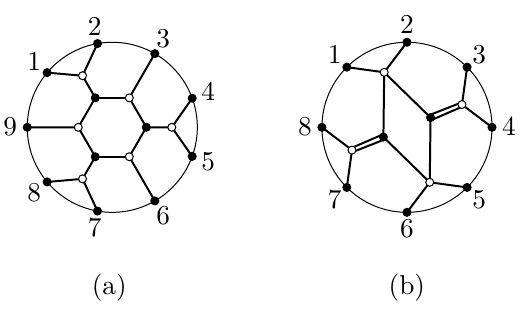
Figure 6. Two of the simplest non-arborizable webs, for (a) G(3 , 9) and (b) G(4 , 8)